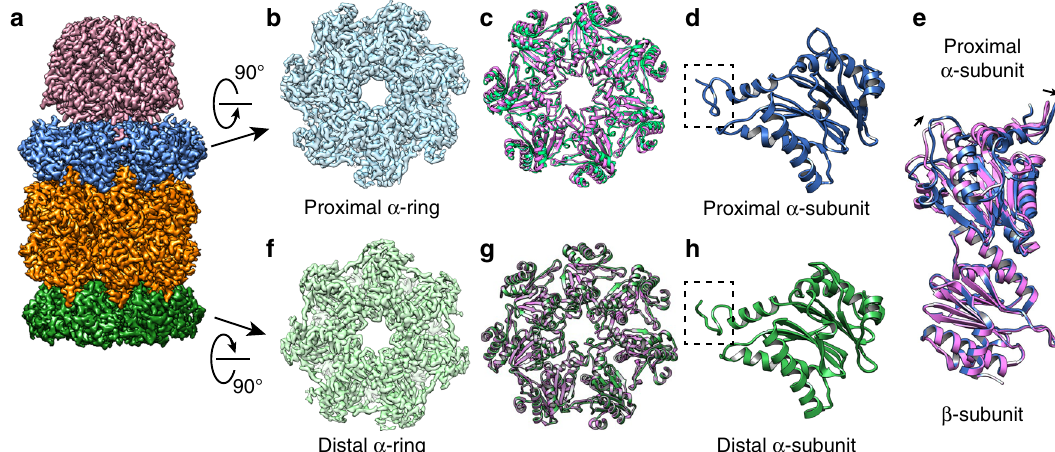
Fig. 3 Single-particle cryo-EM structure of PA26PANc- α WT ββα K66A complex. a Cryo-EM reconstruction of PA26PANc- α WT ββα K66A at a resolution of 2.9 Å. Samples were prepared without substrate LFP peptide substrate present. b Proximal α -ring of the 20S CP. c Ribbon diagram of proximal α -ring (green) overlayed with that of the α -ring in closed conformation without bound activator (purple). Note that the two do not overlap, indicating rotation induced by activator binding. d Ribbon diagram of α -subunits from proximal α -rings. The N-terminus of a-subunit within the dashed box points upwards in an open gate conformation. e Ribbon diagrams of an α -subunit from the proximal α -ring and its interacting β -subunit (green) overlaid with the ribbon diagram of α / β -subunits from a 20S CP without activator bound (purple). Note that the β -subunit is perfectly aligned between the two, but α -subunit is rotated. f The distal α -ring of the 20S CP. g Ribbon diagram of distal α -ring (green) overlayed with that of the α -ring in closed conformation without bound activator (purple). Note that the two overlap nicely. h Ribbon diagram of α -subunits from distal α -rings, where the N-terminus of a-subunit within the dashed box points upwards in an open gate